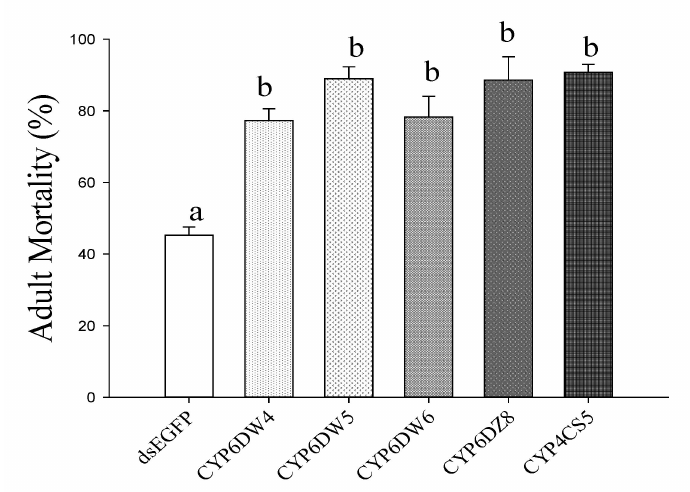
Figure 5. 24 h mortality of Bemisia tabaci MED fed imidacloprid (100 ppm) after five P450 genes silencing. Means for different letters were significantly different ( p <